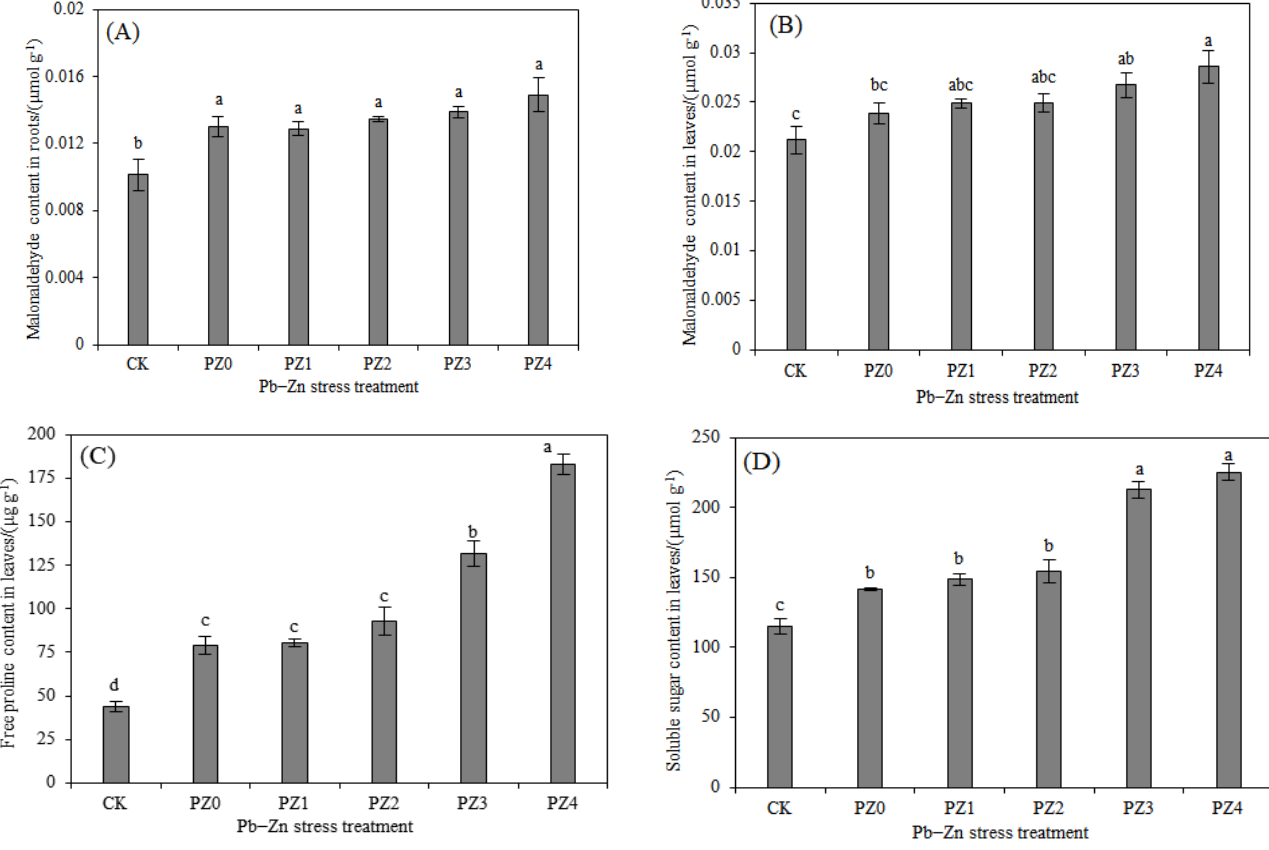
Figure 3. Impacts of different Pb–Zn treatments on malonaldehyde content in roots ( A ), malonaldehyde content in leaves ( B ), free proline content in leaves ( C ) and soluble sugar content in leaves ( D ). Along the x -axis of each graph, CK indicates that the Pb and Zn concentration is 0 (or control), and PZ0, PZ1, PZ2, PZ3 and PZ4 indicate that the Pb concentration are 300 mg/L and that the Zn concentrations are 0, 75, 150, 300 and 600 mg/L, respectively. Vertical bars represent the standard errors of the mean ( n = 3). Different letters indicate significant differences among treatments with different Zn concentrations ( p < 0.05).